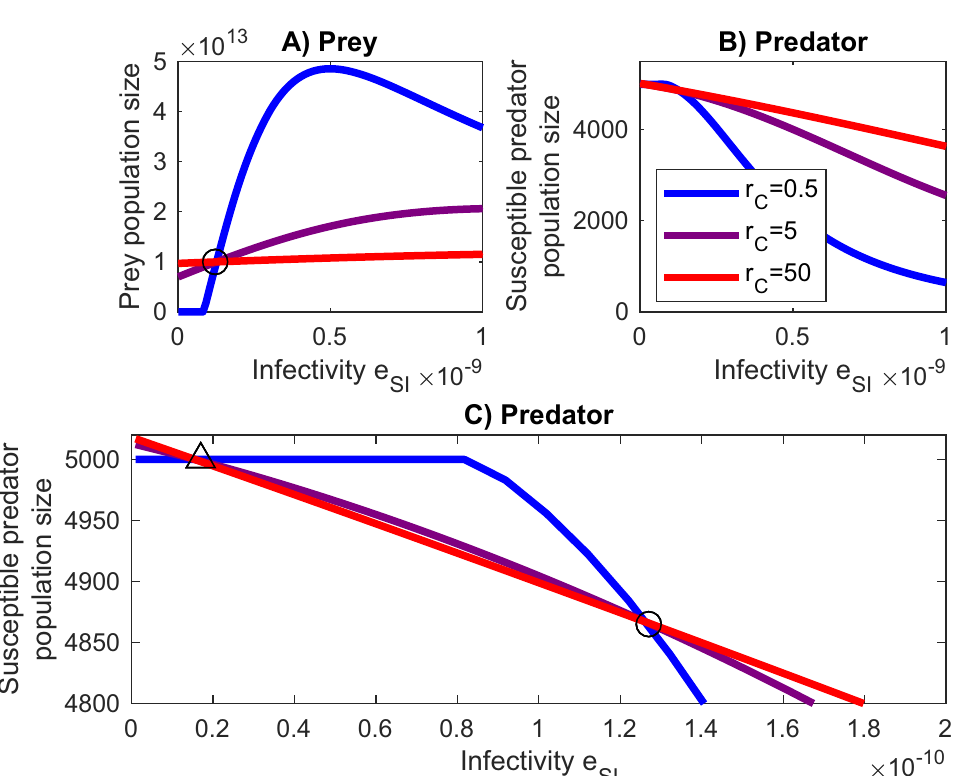
Fig 2. Infectivity affects both prey and predator population sizes. (A) and (B) The population size of the prey and predators, respectively. (C) A closer view to the switch points (o, Δ ) in the predator population. Red, purple and blue lines represent fast (r C = 50), medium (r C = 5) and slow (r C = 0.5) growth rates. The predator’s grazing rate g = 3 . 0 � 10 −4 and the infective proportion of the prey α = 0.001.